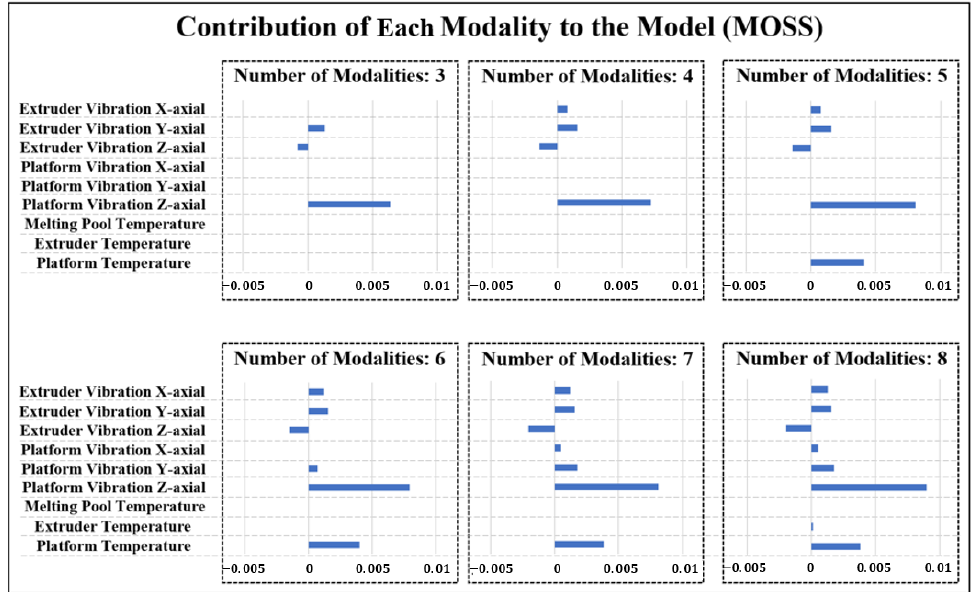
Figure 6. Contribution of each Modality for Flatness Prediction with Different Numbers of Modalities in MOSS.